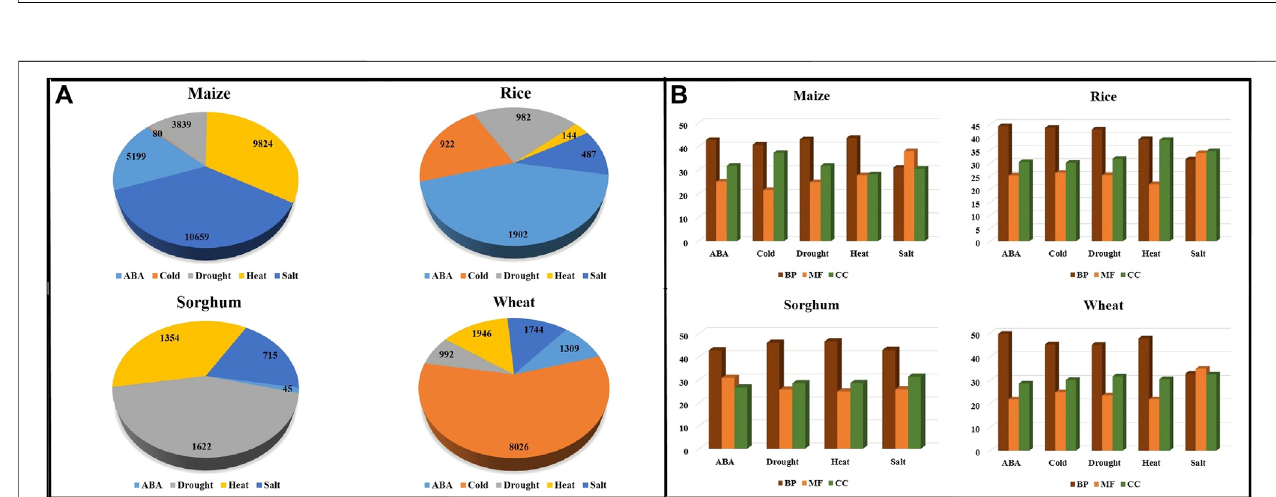
FIGURE 5 | Distribution of (A) annotated contigs across different abiotic stresses in the crops. (B) GO terms — Biological Process (BP), Molecular Function (MF), and Cellular Component (CC) across abiotic stress in crops.